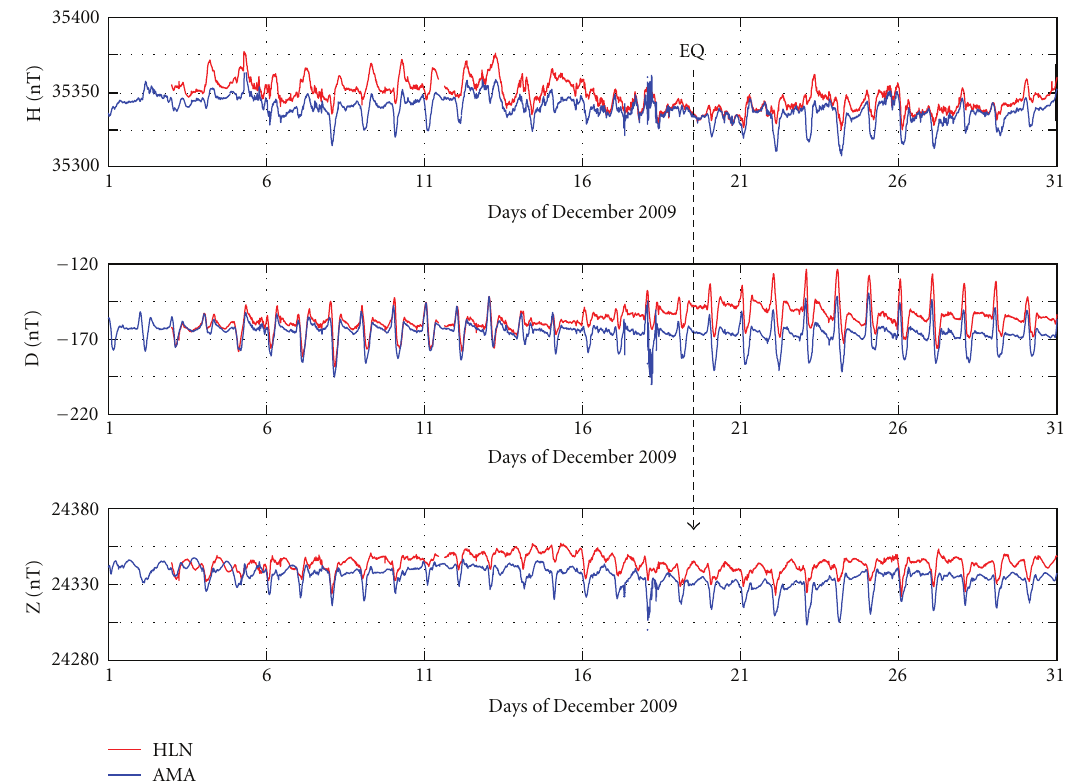
Figure 4: One-minute average values of the H- (top), D- (middle), and Z- (bottom) components recorded at the HLN (red curves) and AMA (blue curves) stations in December 2009.